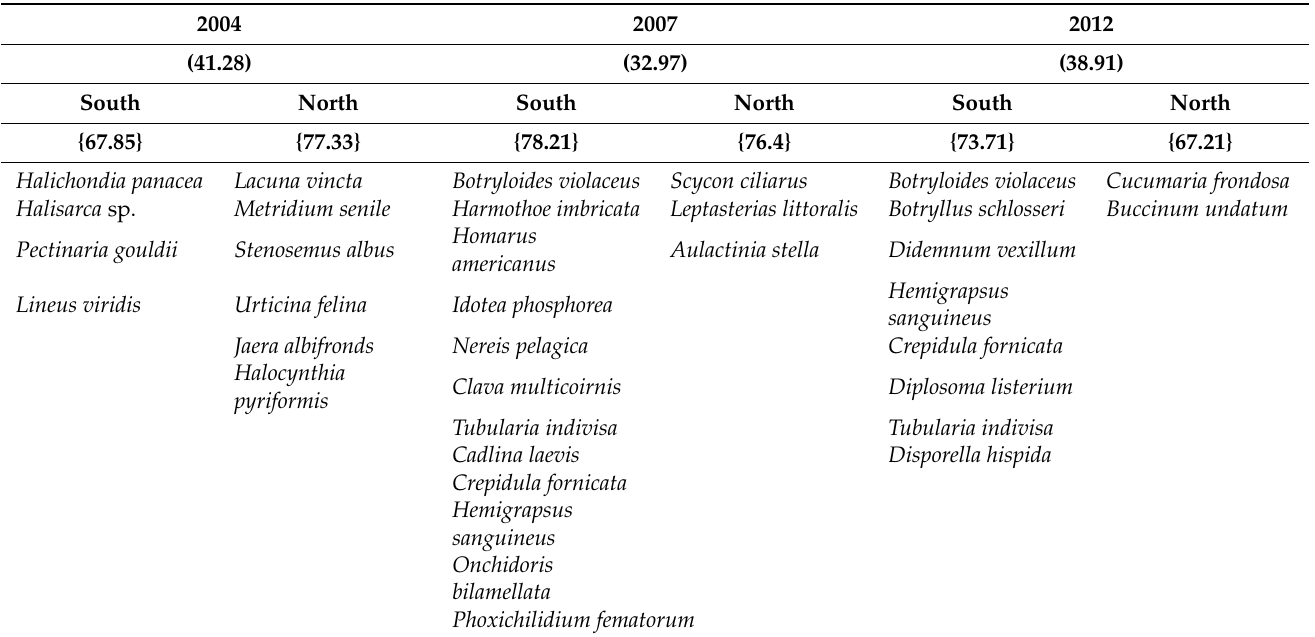
Table 5. Species that contributed most to dissimilarity (up to 70%) between regions determined by SIMPER. Average Bray-Curtis dissimilarity between regions in parentheses. Average Bray-Curtis similarity within regions in